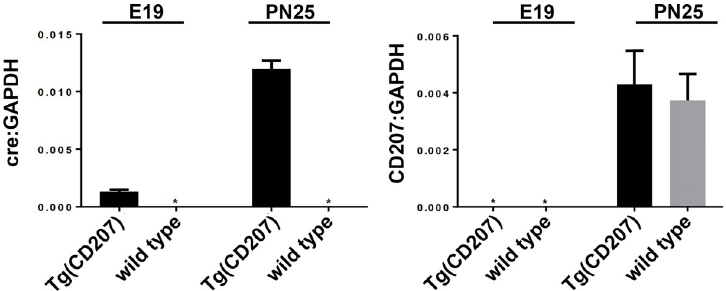
Fig 8. Expression of human CD207-driven cre recombinase occurs earlier in development than expression of endogenous murine CD207. RNA was extracted from trunk skin of embryos of the indicated genotype at post-coital day 19 (E19) and from the ear skin of mice of the indicated genotype at 25 days of age postnatal (PN25). RNA was analyzed by quantitative RT-PCR for the expression of cre recombinase, CD207, and GAPDH. The ratios of C t for cre recombinase to C t for GAPDH are shown in the plot on the left; the ratios of C t for CD207 to C t for GAPDH are shown in the plot on the right. Results were combined from three mice for each age and genotype. The E19 Tg(CD207) group had 2 males and one female, while the wild type group had 2 females and one male. � , no expression detected.